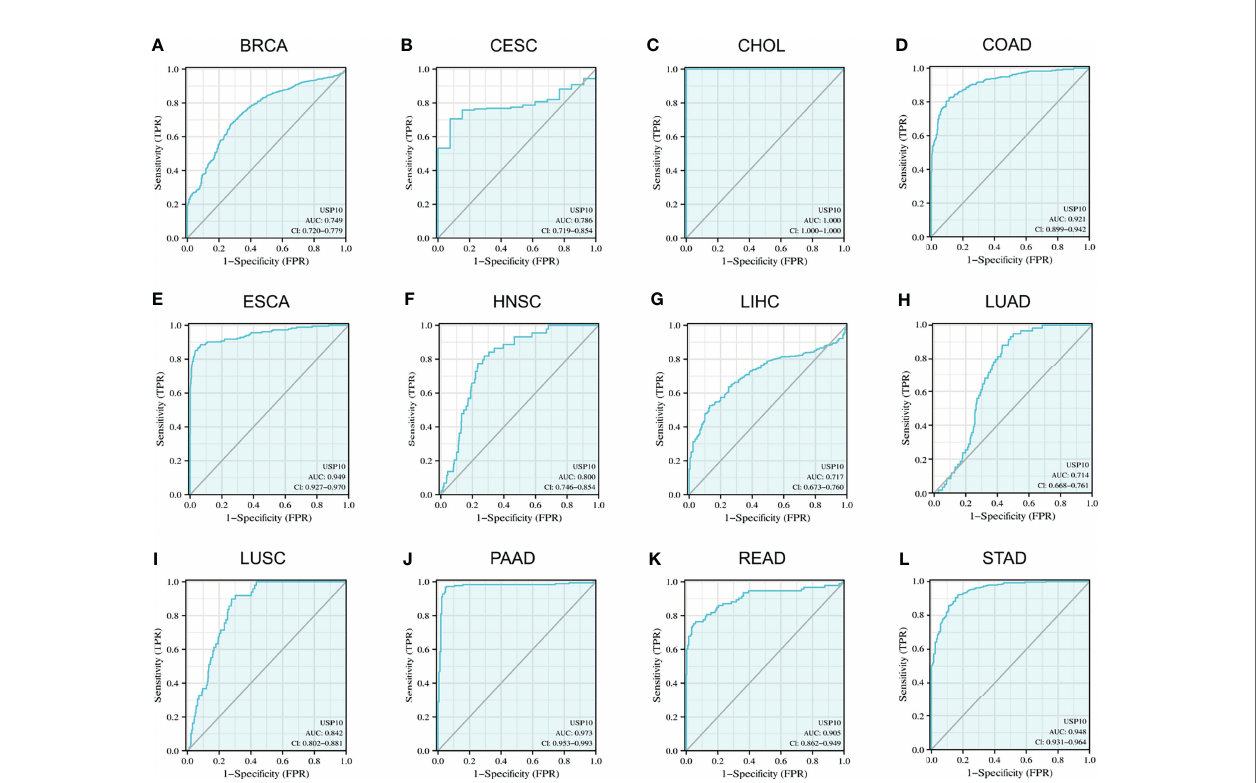
FIGURE 3 | Receiver operating characteristic (ROC) curves for USP10 in representative tumors. (A) BRCA, (B) CESC, (C) CHOL, (D) COAD, (E) ESCA, (F) HNSC, (G) LIHC, (H) LUAD, (I) LUSC, (J) PAAD, (K) READ, (L) STAD. Values under the ROC curve ranges from 0.5 to 1. The closer the area under the curve (AUC) is to 1, the better the diagnosis. The horizontal coordinate is the False Positive Rate (FPR), and the vertical coordinate is the True Positive Rate